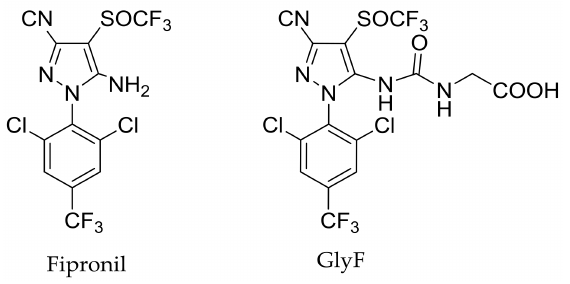
Figure 1. Chemical structure of fipronil and the glycinergic–fipronil conjugate (GlyF)